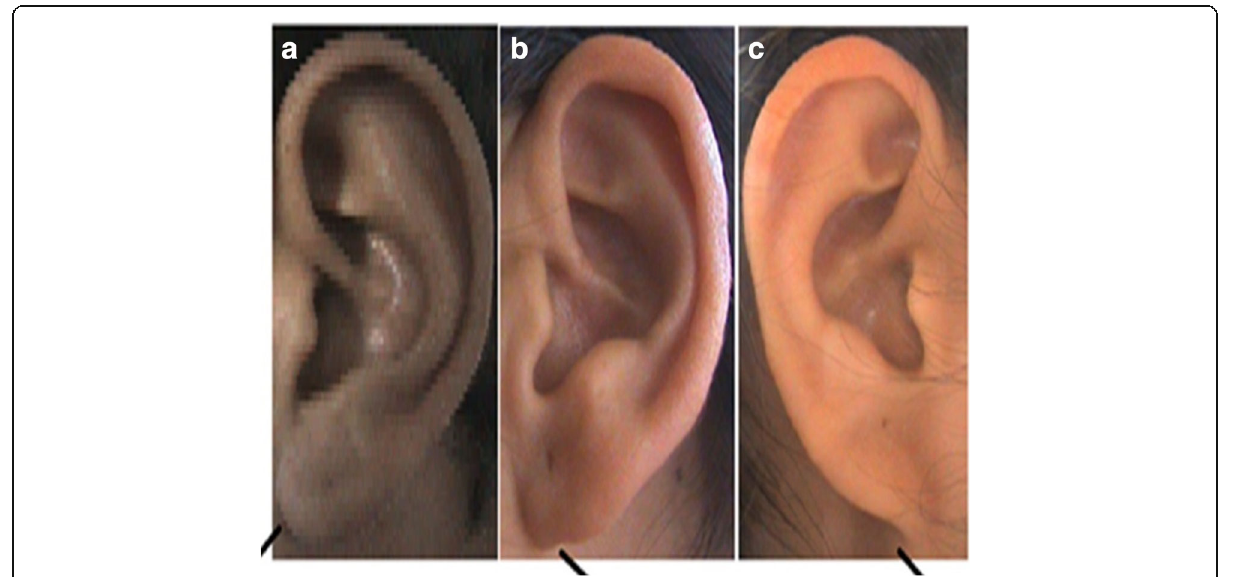
Fig. 5 Photographs showing the different forms of the earlobe attachment. a Free. b Partially attached. c Attached